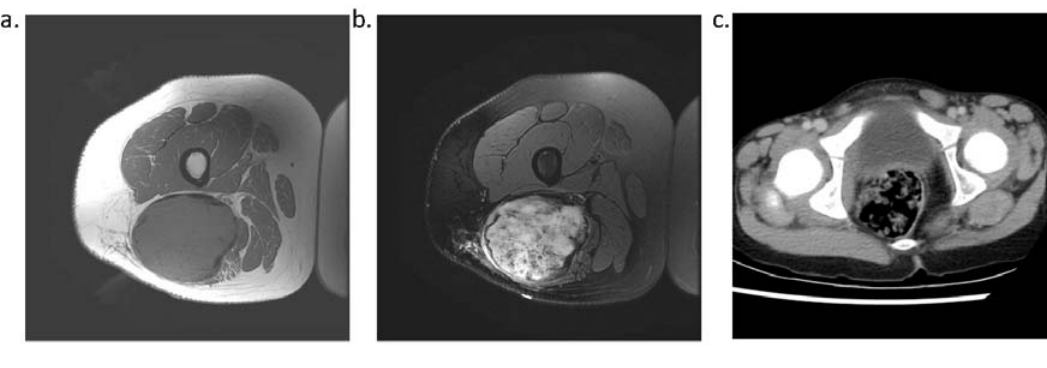
Figure 2. T1 ( a ) and T2 ( b ) weighted MRI and contrast-enhanced CT ( c ) of desmoid tumors provide anatomic information useful in the management of desmoid